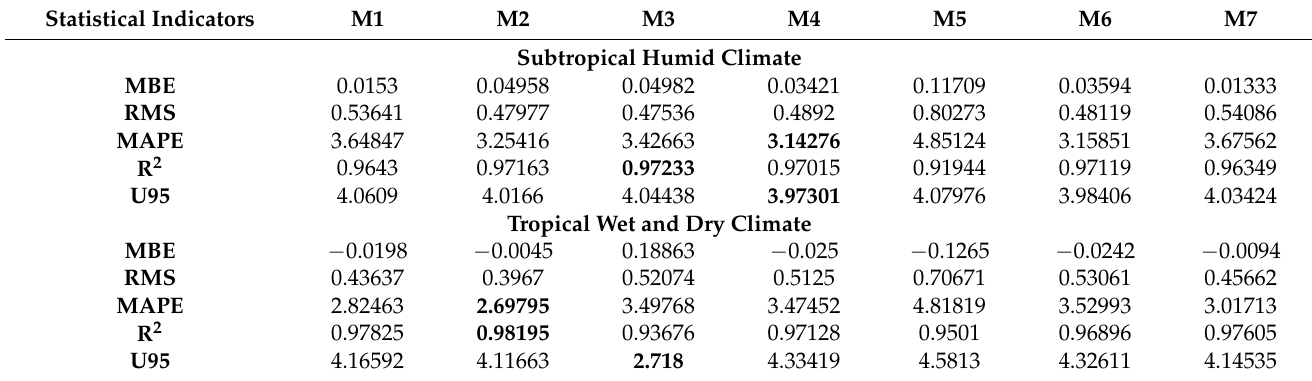
Table 4. Statistical indicator values for Category-1 ML models for different climatic